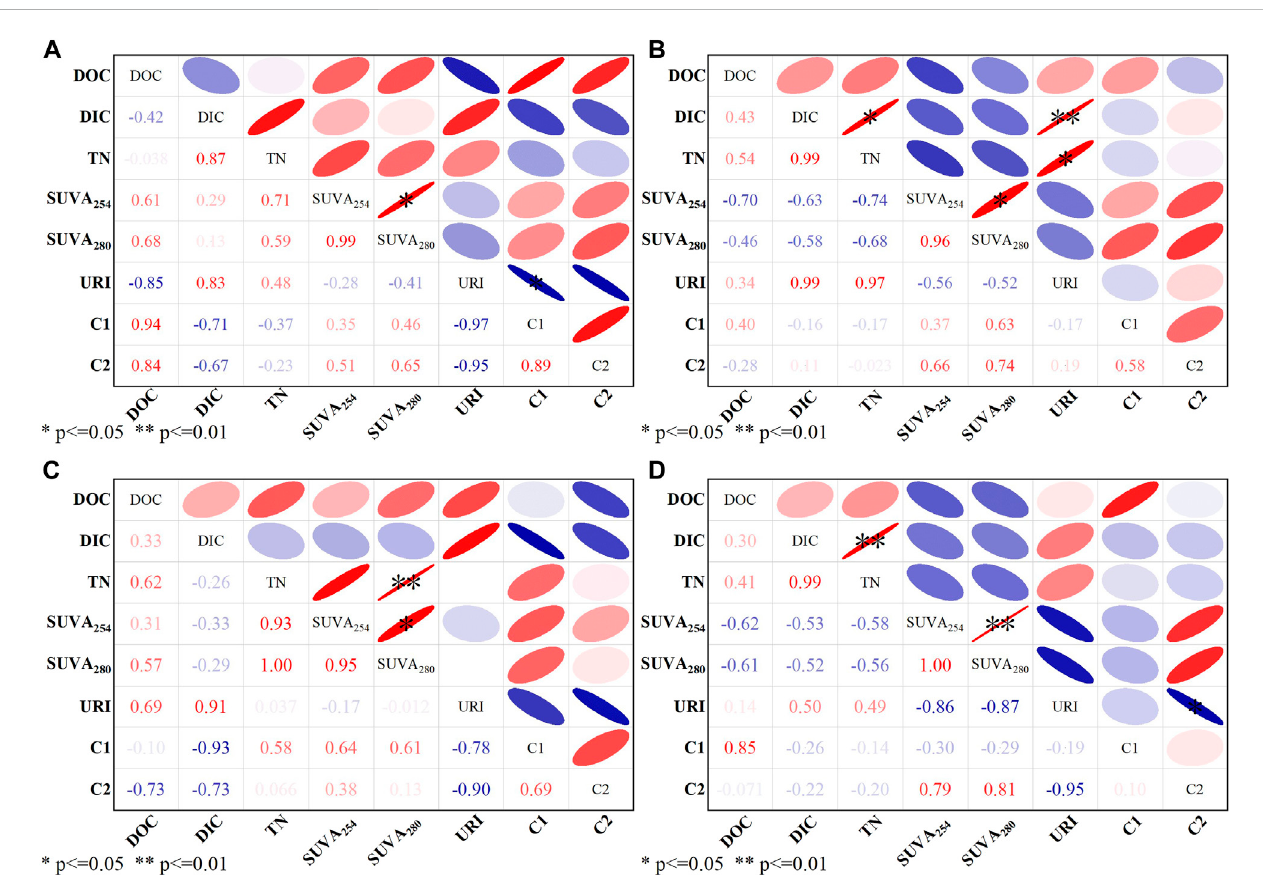
FIGURE 5 Pearson correlation analysis of spectral parameters of Chlorella vulgaris and Scenedesmus obliquus. (A) Chlorella vulgaris EOM; (B) Chlorella vulgaris IOM; (C) Scenedesmus obliquus EOM; (D) Scenedesmus obliquus IOM (n = 16).